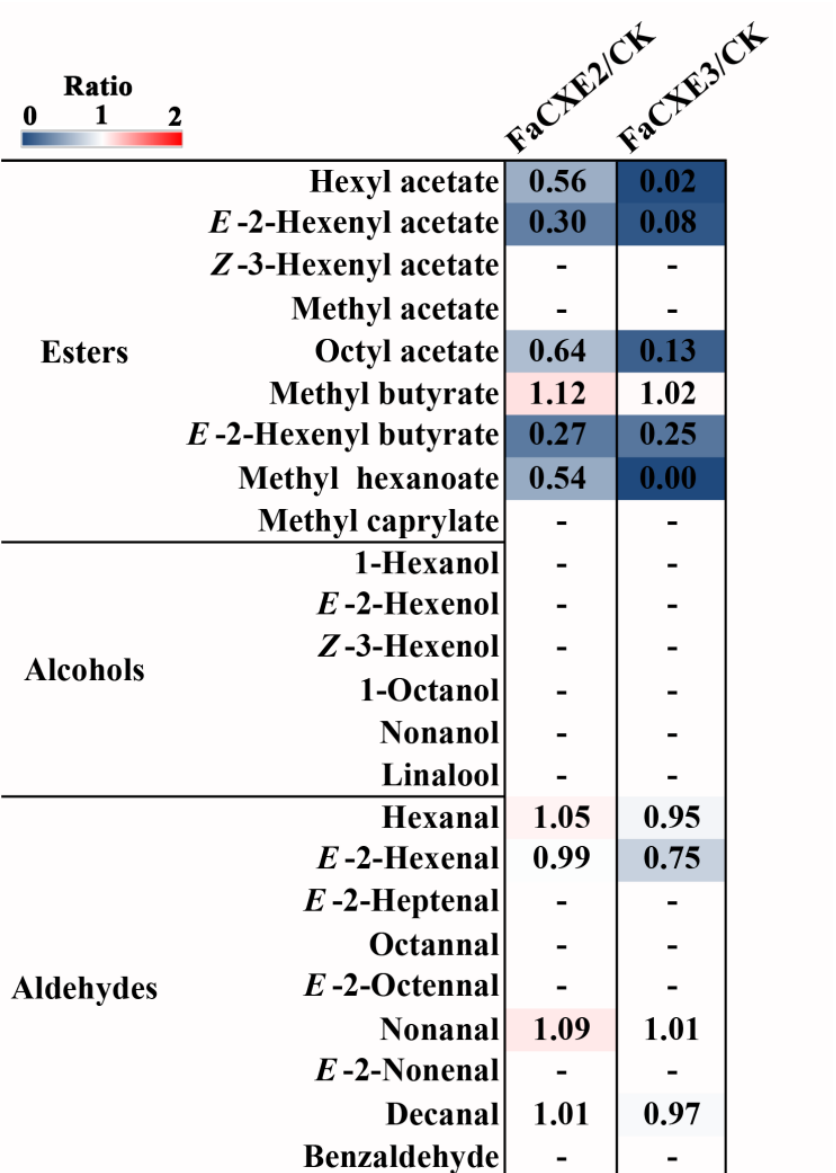
Figure 4. Hydrolysis analysis of volatile substances extracted from strawberry fruit by recombinant FaCXE2 and FaCXE3 proteins. The volatile compounds extracted from strawberry red fruit (SPE) were used as the substrate, and the recombinant FaCXEs were used as the enzyme. The controls (CK) were treated with boiled recombinant protein. Numbers represent ratio of volatiles in the hydrolysis assays compared with the controls, “-” means not detected. All data are presented as mean of three biological replicates.